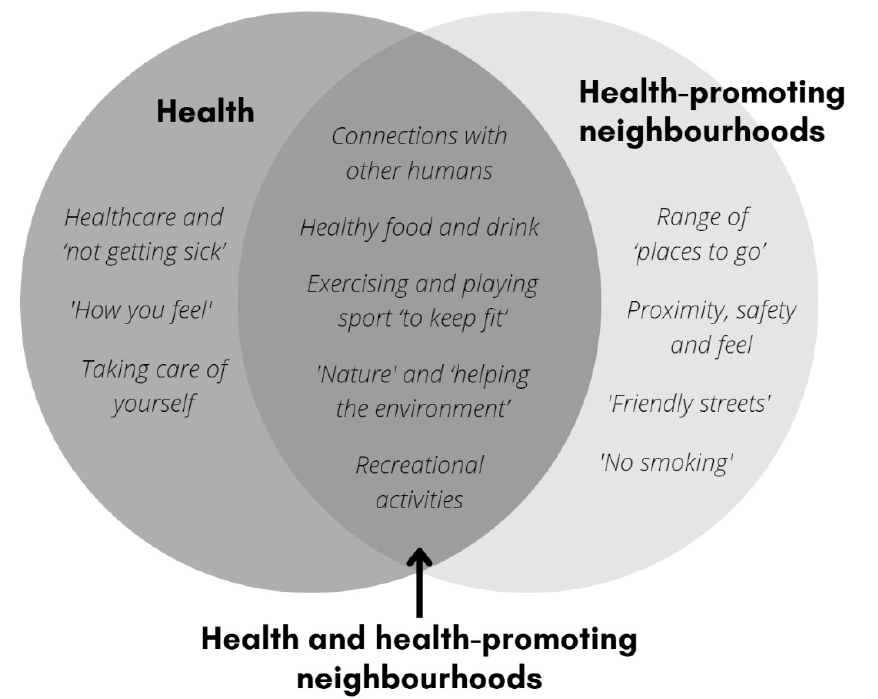
Figure 2. Framework of child-centred topics for health and health-promoting neighbourhoods.